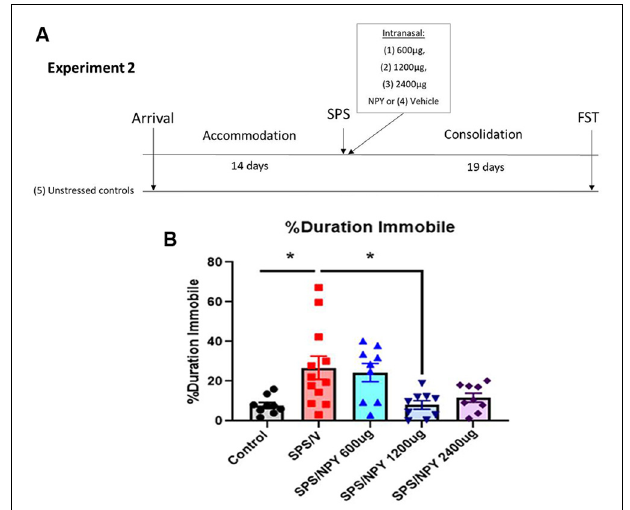
FIGURE 3 | Dose response effect of intranasal NPY on depressive-like behavior. The experimental protocol is shown (A) . Animals received one of the increasing doses of intranasal NPY (SPS/NPY 600 µ g ; SPS/NPY 1,200 µ g ; SPS/NPY 2,400 µ g ) or vehicle (SPS/V) immediately after the SPS stressors and were tested on the FST 19 days later, along with unstressed controls (A) . The animals were measured for percent duration immobile (B) . Each point represents values for an individual animal. Means ± SEM are shown. One-way ANOVA was performed and post hoc Tukey was used to determine differences between groups. * p ≤